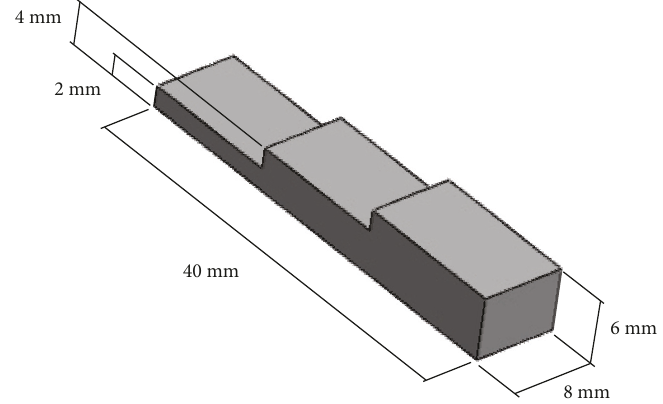
Figure 2: Geometry and dimensions for the titanium injection-molded part.